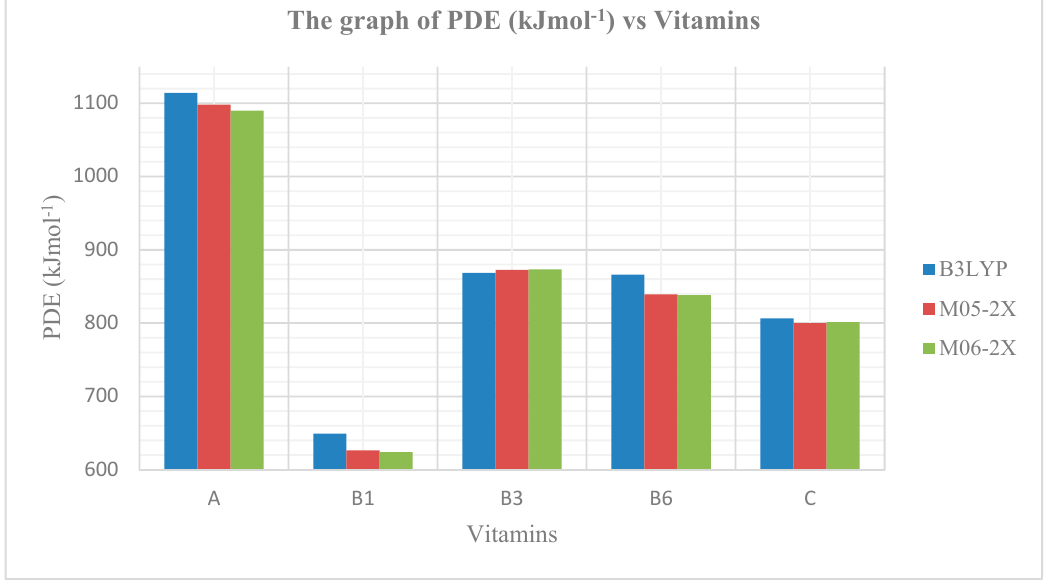
Figure 5. Comparison of proton dissociation enthalpies (PDEs) of the dietary vitamins.